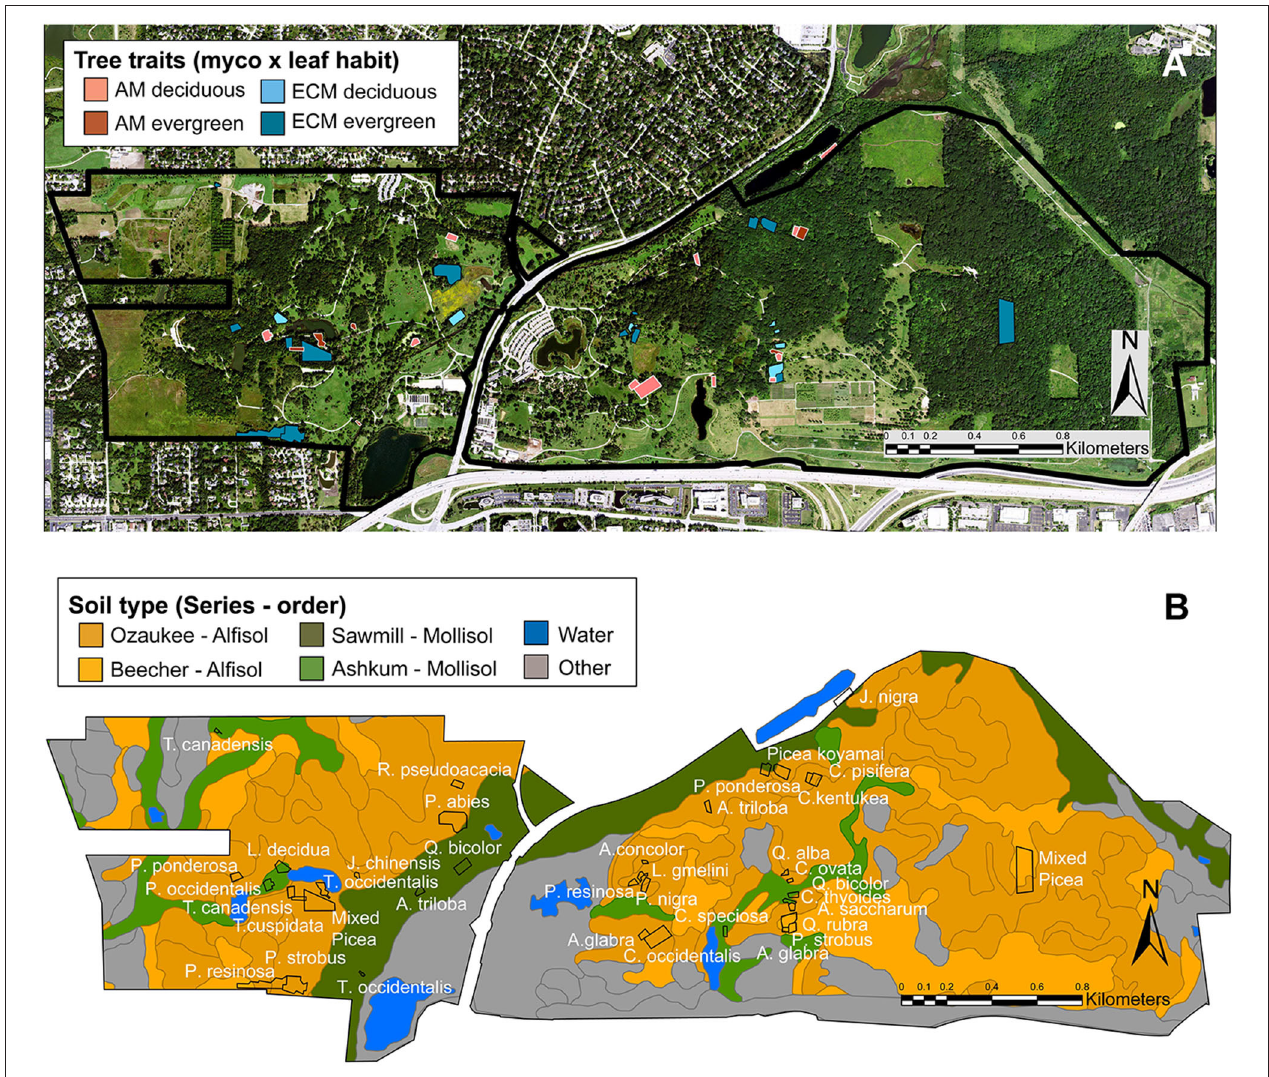
FIGURE 1 | Locations of forestry plots at The Morton Arboretum. Trees varying in mycorrhizal association (AM or ECM) and leaf habit (deciduous or evergreen) (A) were planted as monoculture plots on Alfisols (Ozaukee and Beecher soil series) and Mollisols (Sawmill or Ashkum soil series) (B) . In (A) , pink, AM plots; blue, ECM plots; light hues, deciduous plots; dark hues, evergreen plots. In (B) , dark orange, Ozaukee series (Alfisol); light orange, Beecher series (Alfisol); dark green, Sawmill series (Mollisol); light green, Ashkum series (Mollisol); blue, water; gray, other soil